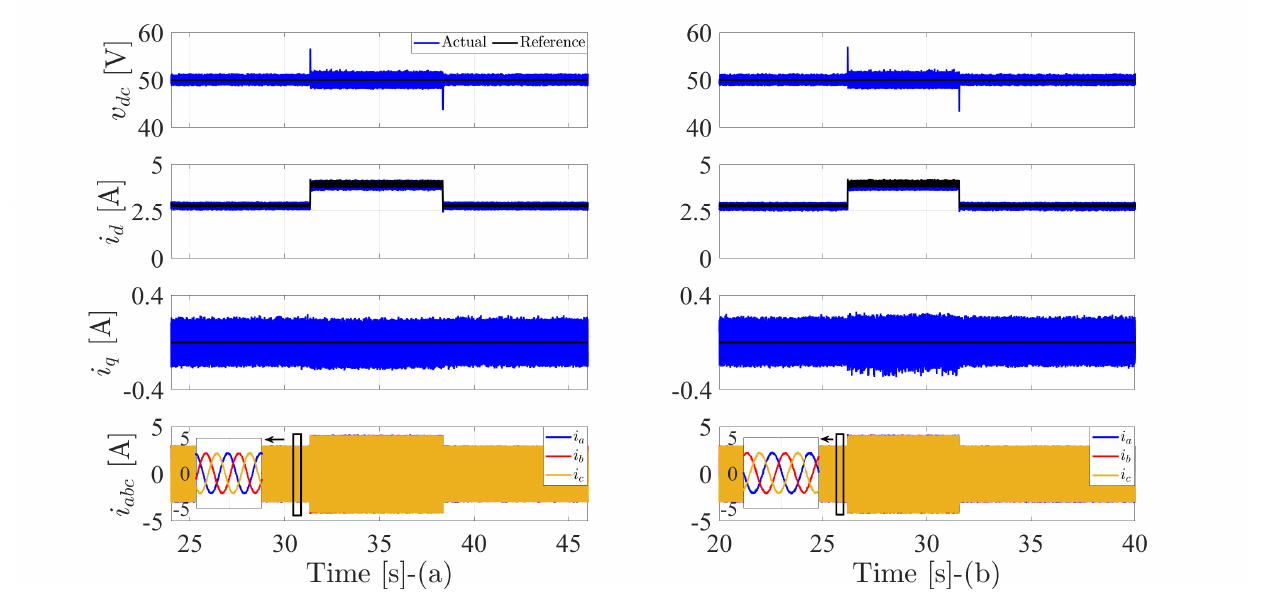
Figure 13. Performance of the inverter control: ( a ) conventional FS-MPC and ( b ) The proposed FS-MPC with switching frequency